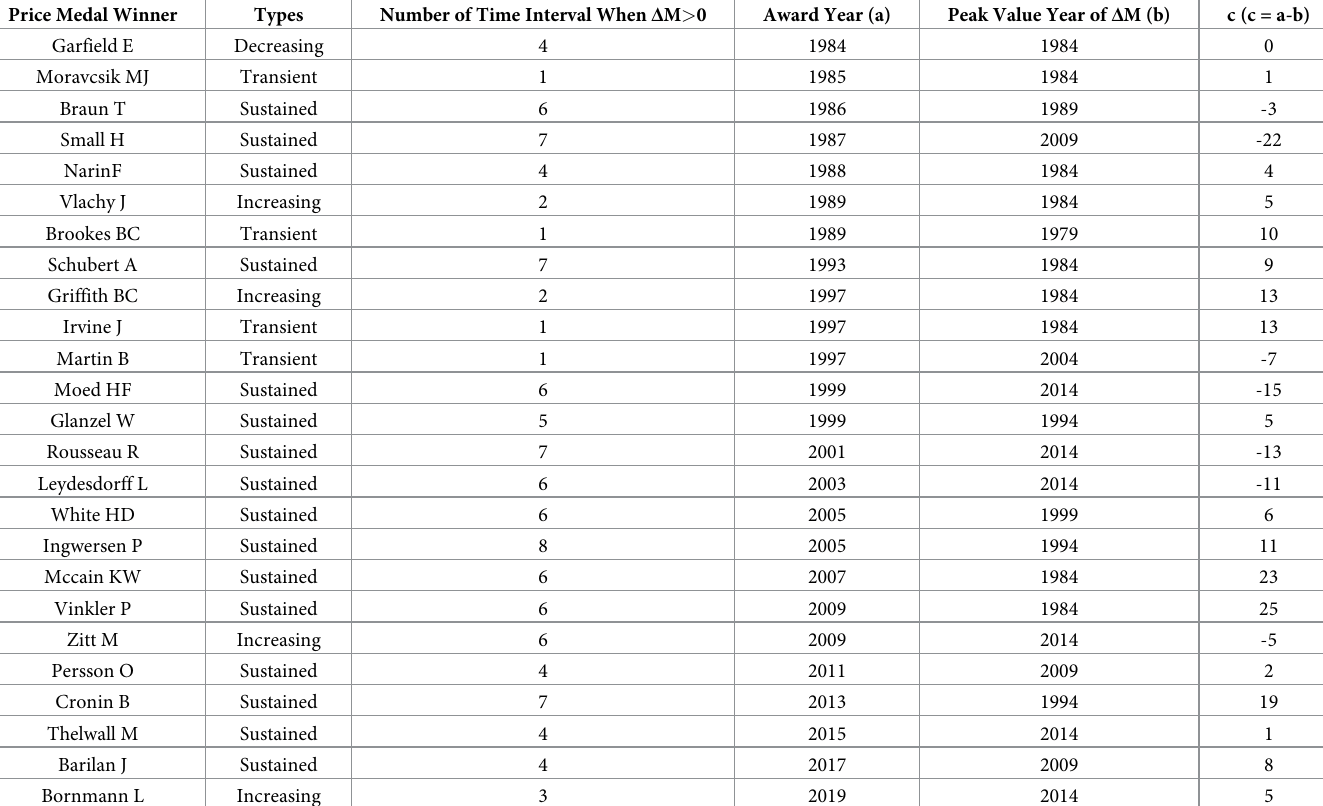
Table 9. The Δ M value of Price Medal winners and the correlation between the peak value of Δ M and the award